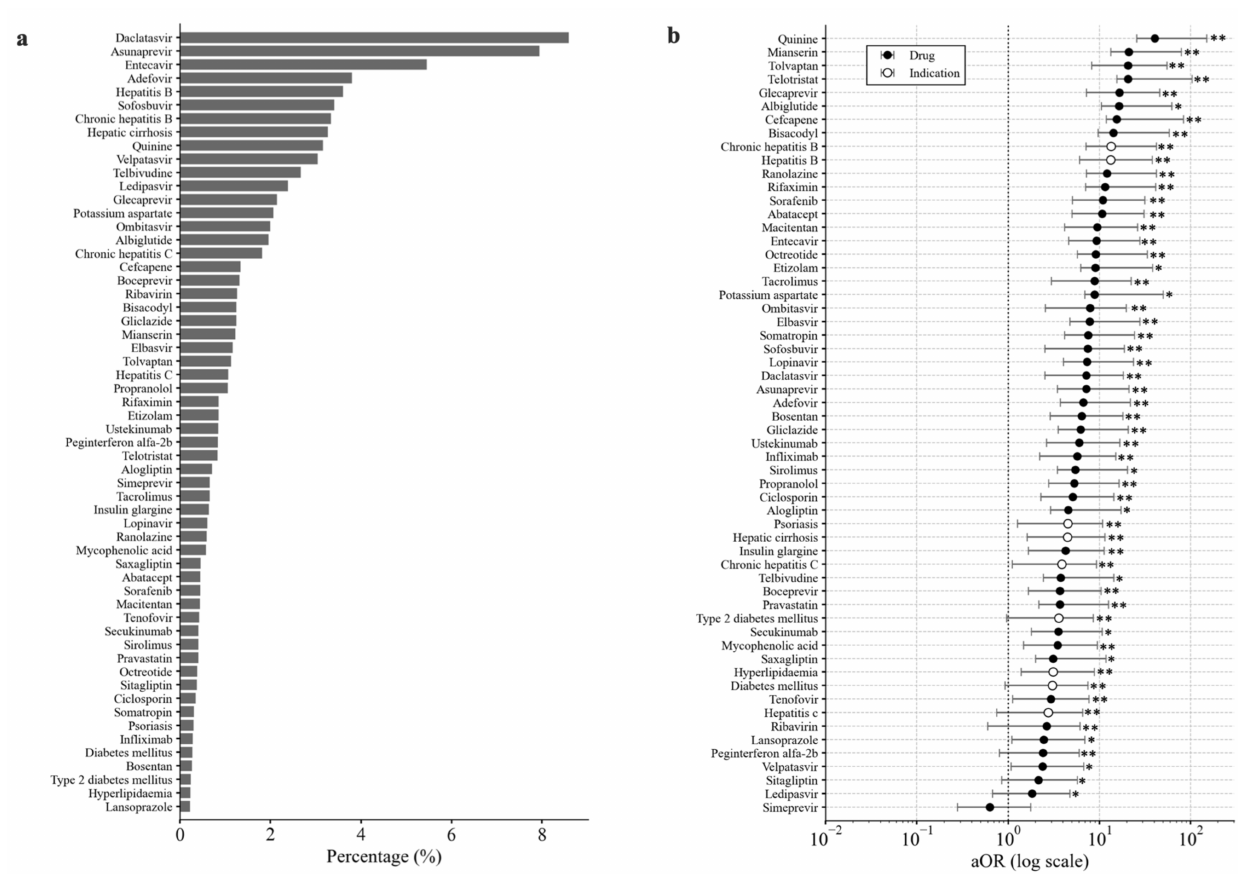
Figure 4. ( a ) Percentage of records with LMT among records with each variate factor. ( b ) Multivariate adjusted odds ratios (aOR) for the reported risk of death shown for each factor. Significant findings (by the Wald test) are indicated with asterisks (* p < 0.05, ** p < 0.01), and 95% confidence intervals are shown as